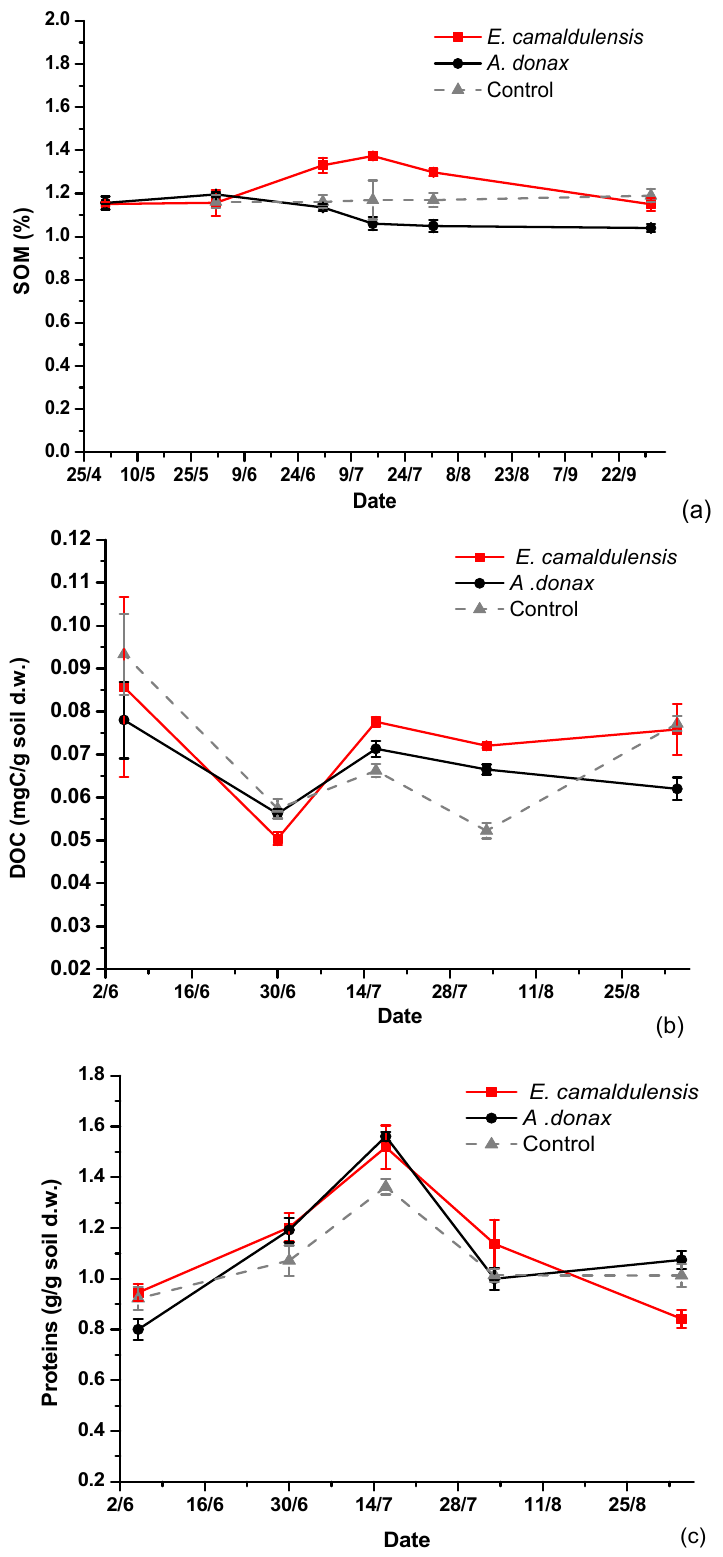
Figure 2. ( a ) Soil organic matter (SOM); ( b ) dissolved organic C (DOC); and ( c ) protein content in pots planted with E. camaldulensis and A. donax and irrigated with primary treated wastewater. Control refers to average of freshwater treated pots since no differences were observed between plant